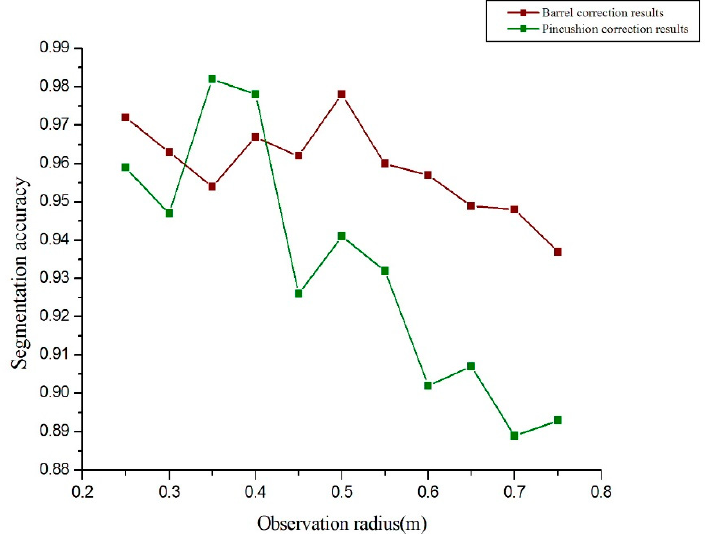
Figure 12. Segmentation accuracy as a function of observation radius after two types of distortion.